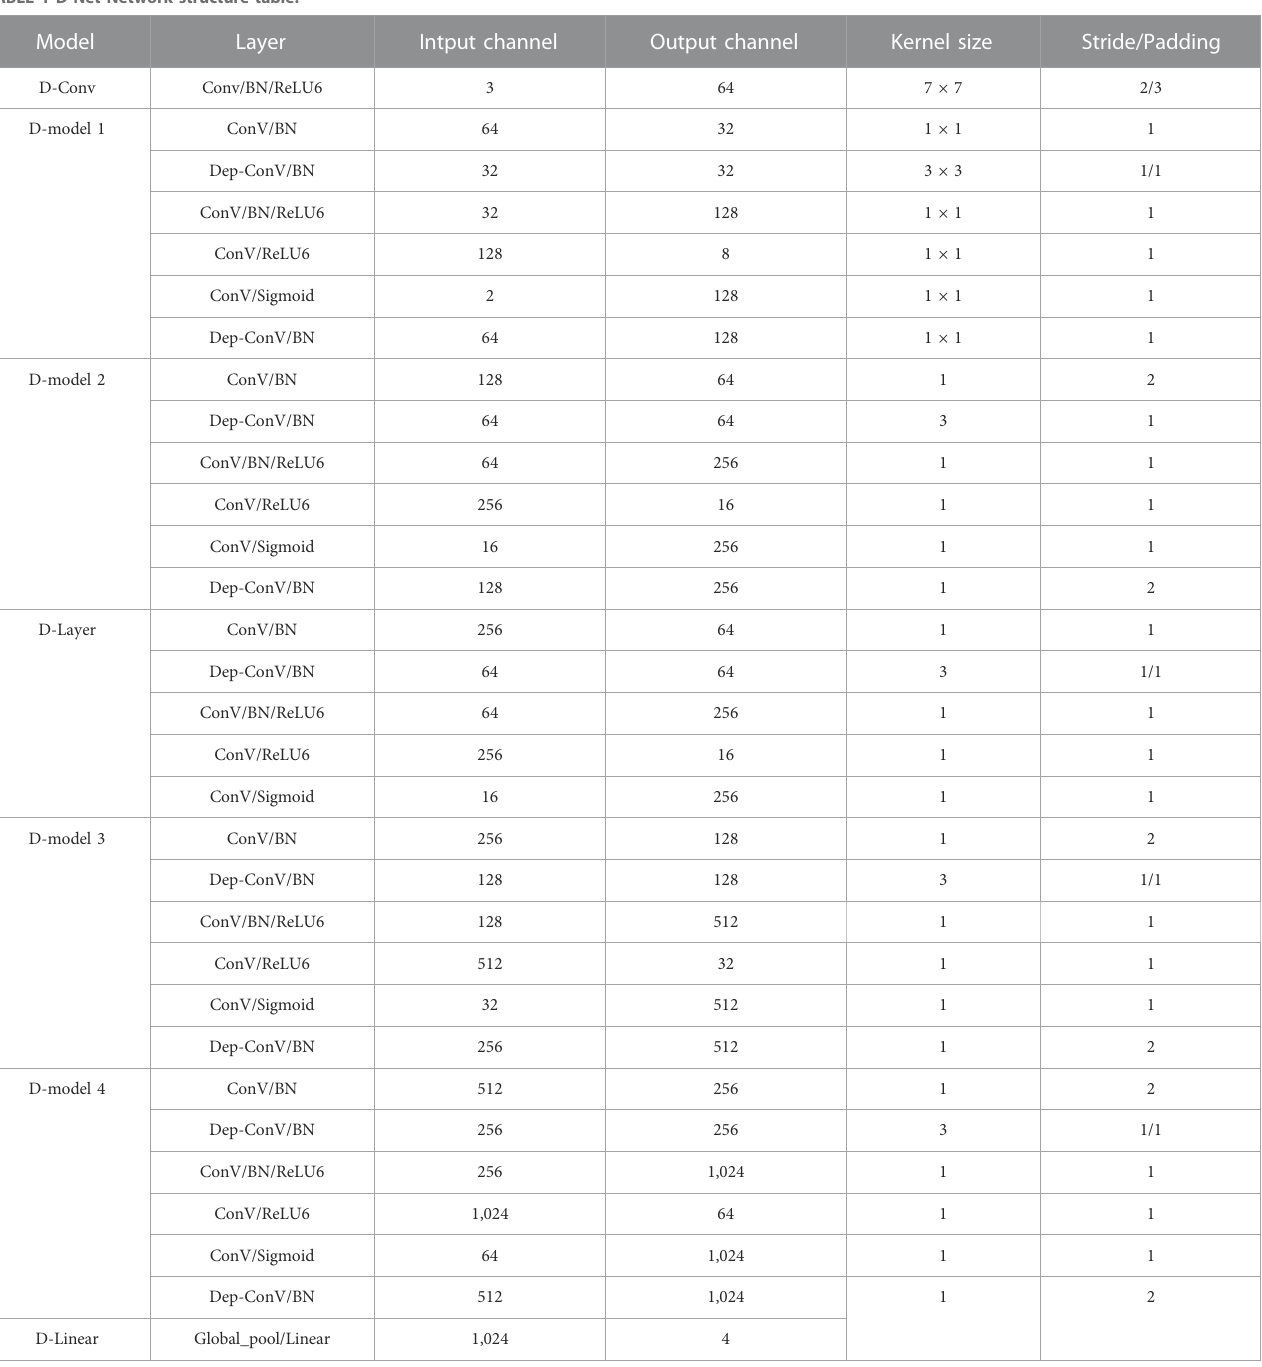
TABLE 1 D-Net Network structure table.